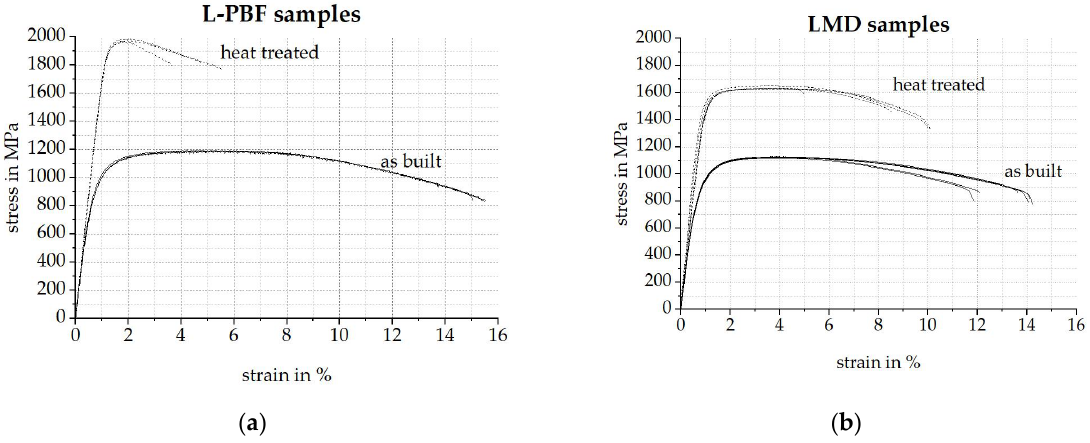
Figure 12. ( a ) Stress–strain curves for L-PBF samples and ( b ) LMD samples in the as-built and heat-treated states.